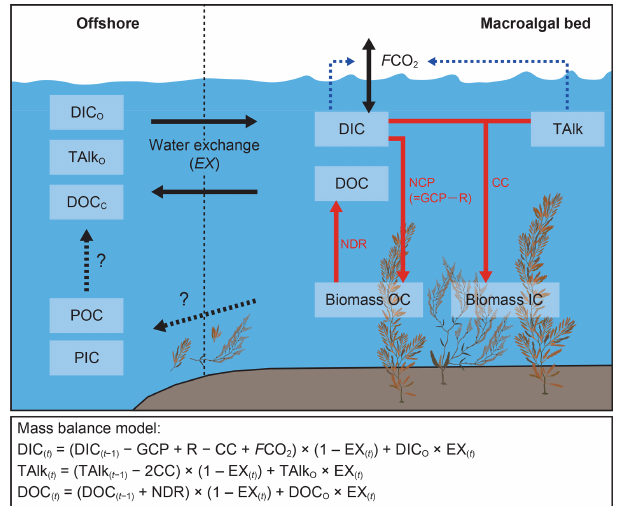
Figure 2. Schematic diagram of the different carbon pools and flows in and around macroalgal beds. Black arrows indicate car- bon flows between macroalgal beds and the outside of the sys- tem, black dashed arrows with question marks denote carbon flows that were not evaluated in this study, and red arrows indicate ef- fects of community metabolism on carbon pools in macroalgal beds. Blue dashed arrows indicate that dissolved inorganic carbon (DIC) and total alkalinity (TAlk) regulate air–water CO 2 exchange fluxes ( F CO 2 ). DIC concentrations in macroalgal beds are regulated by net community production (NCP), community calcification (CC), F CO 2 , and mixing with offshore DIC (DIC O ). NCP is calculated by subtracting community respiration (R) from gross community production (GCP). TAlk in macroalgal beds is regulated by CC and mixing with offshore TAlk (TAlk O ). Dissolved organic carbon (DOC) concentrations in macroalgal beds are regulated by net DOC release (NDR) and mixing with offshore DOC (DOC O ). Organic carbon (OC) and inorganic carbon (IC) of macroalgal biomass are produced by NCP and CC, respectively, and some of each is ex- ported offshore in particulate form (POC and PIC, respectively). Mass-balance models simulated the diurnal changes and budgets of DIC, TAlk, and DOC in the macroalgal bed at hourly time steps ( t ) in this